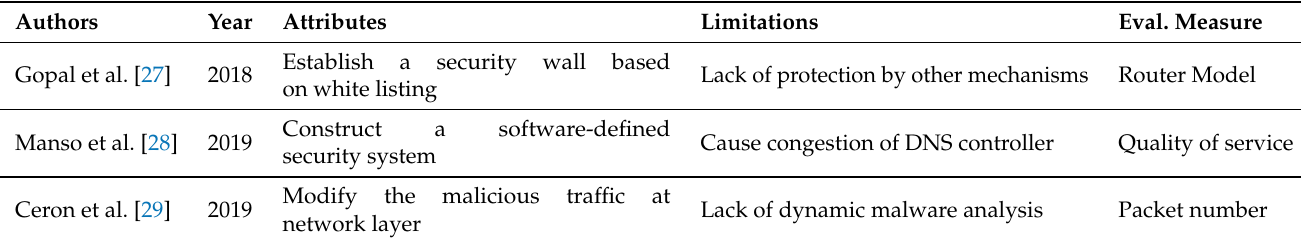
Table 2. Overview of the mitigation methods.